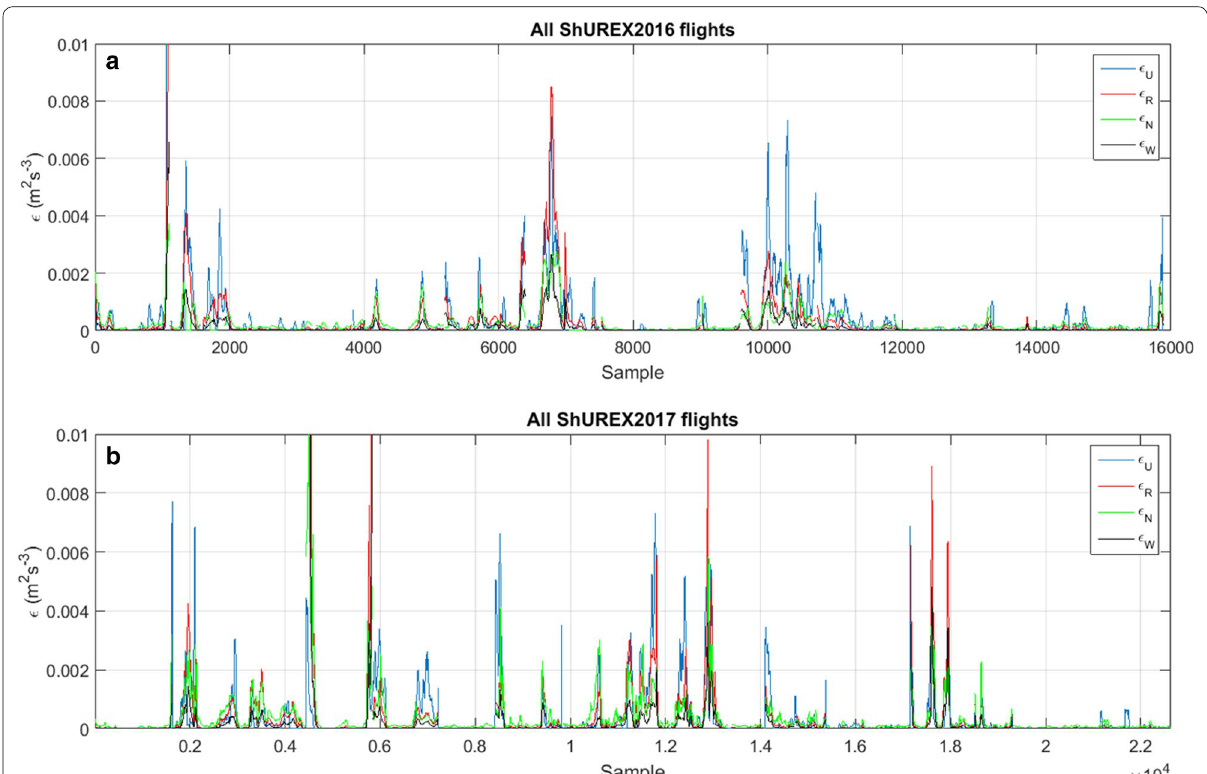
Fig. 13 a Concatenation of all ε U (blue), ε R (red), ε W (black) and ε N (green) profiles from the ShUREX2016 UAV flights in chronological order. b Same as a for ShUREX2017 UAV flights